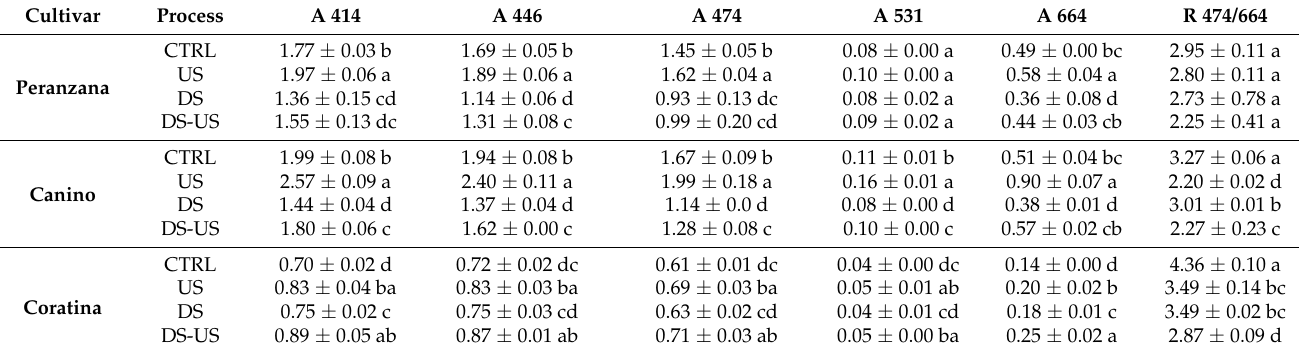
Table 4. Influences of different EVOOs extraction methods on spectrophotometric UV-Vis absorbtion peaks. Cultivar